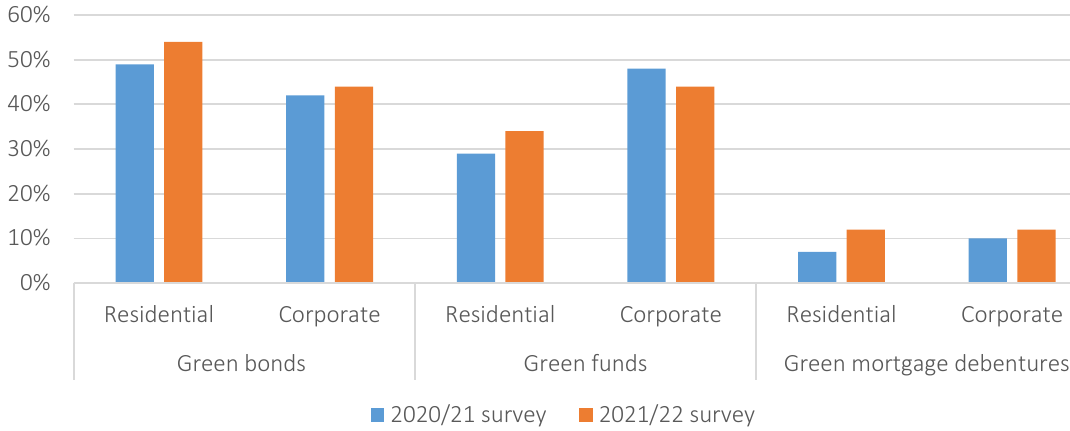
Figure 1. Residential and corporate knowledge of green financial products